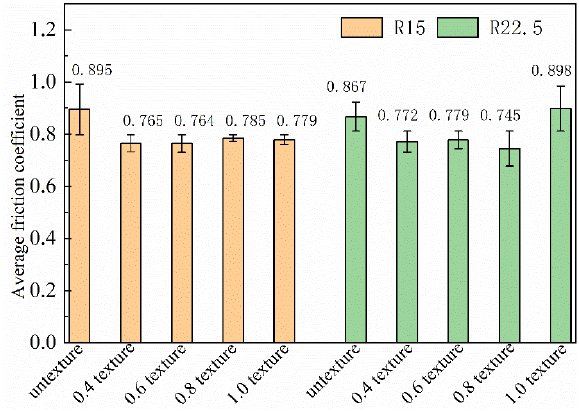
Figure 5. Friction coefficient error band of different samples.